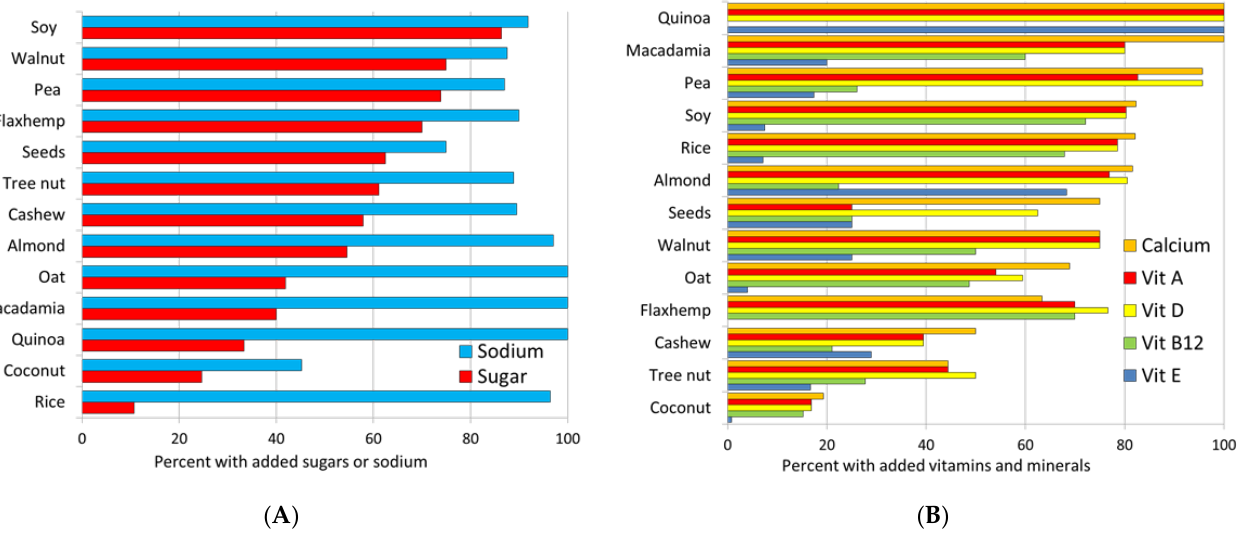
Figure 2. Percent of PB milk alternatives with added sugars and sodium ( A ), and percent of PB milk alternatives fortified with micronutrients ( B ). PB are classified by main ingredient.